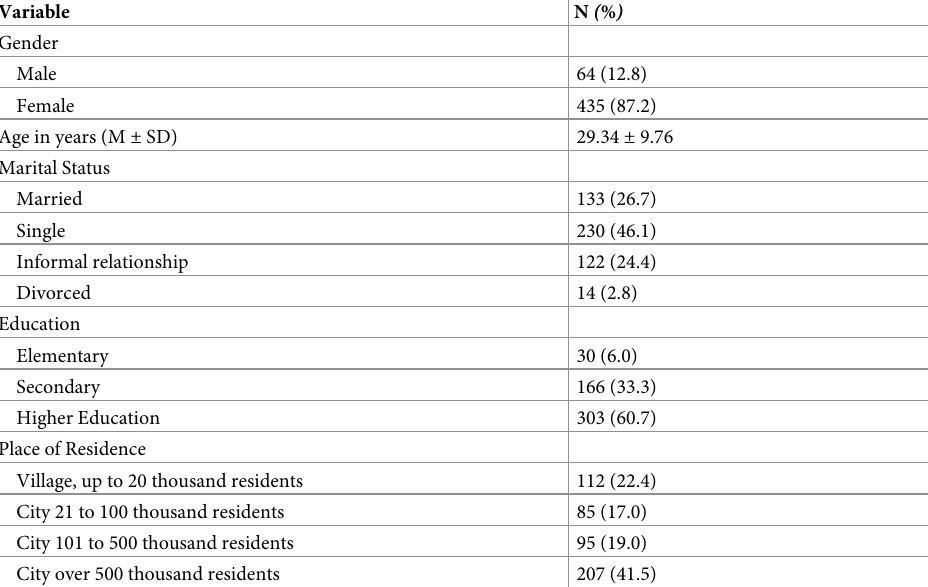
Table 1. Sociodemographic variables in the studied sample ( N =